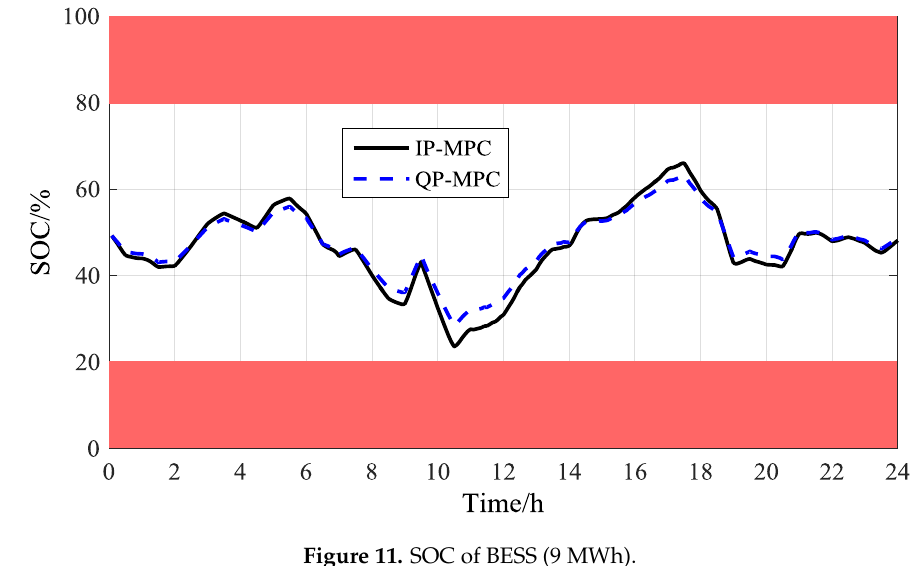
Figure 11. SOC of BESS (9 MWh).